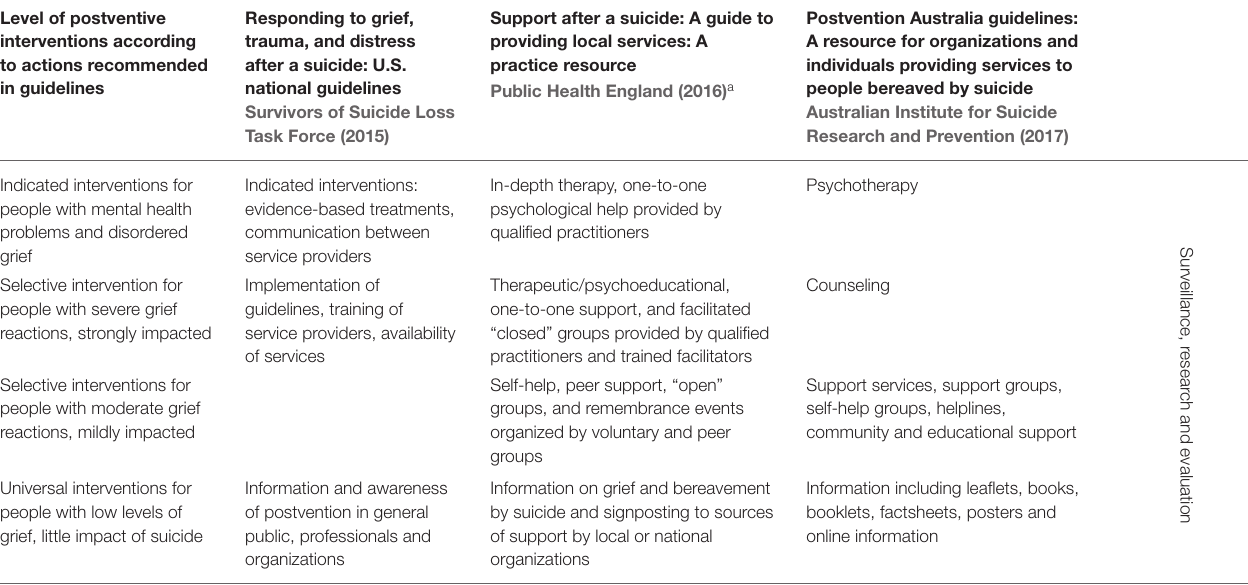
TABLE 6 | Postvention service delivery according to level of impact of